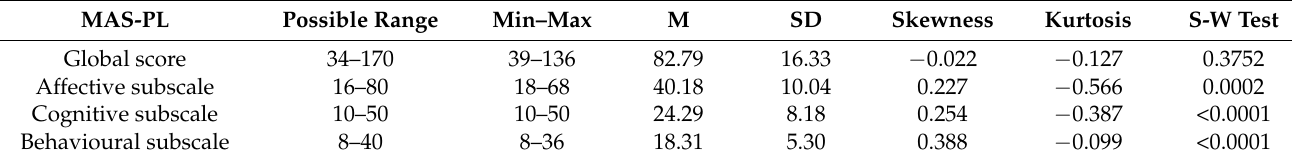
Table 3. Basic distribution of MAS-PL scores in the survey (N = 540).